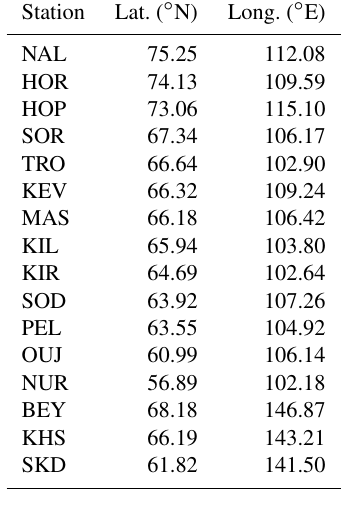
Table 1. List of the geomagnetic coordinates of magnetometers. Station